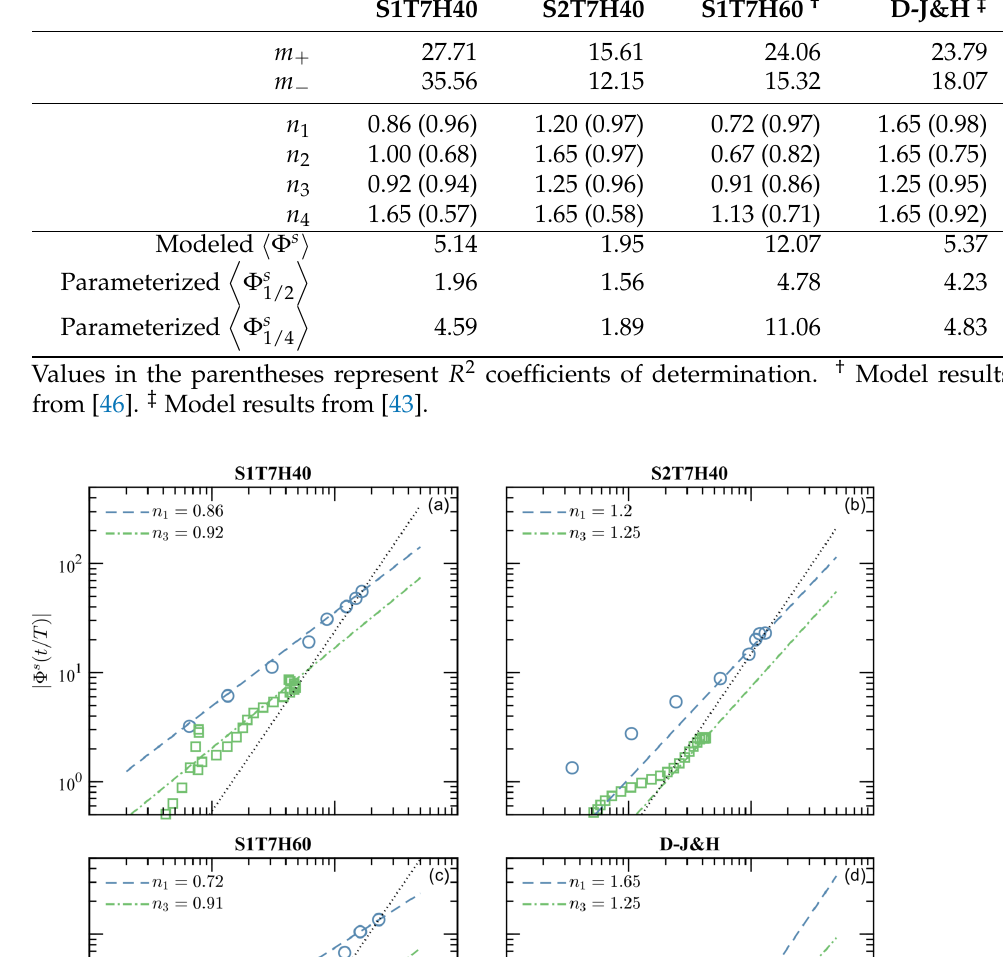
Table 4. A summary of parameters for the sediment transport rate from four different SedWaveFoam wave flume studies.